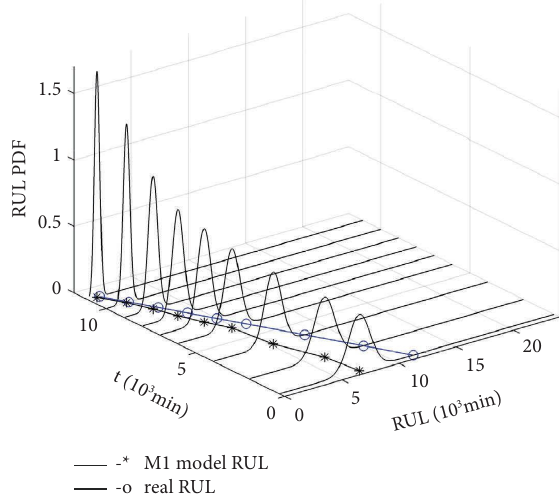
Figure 6: RUL estimation of the M1 model in a1 sample.